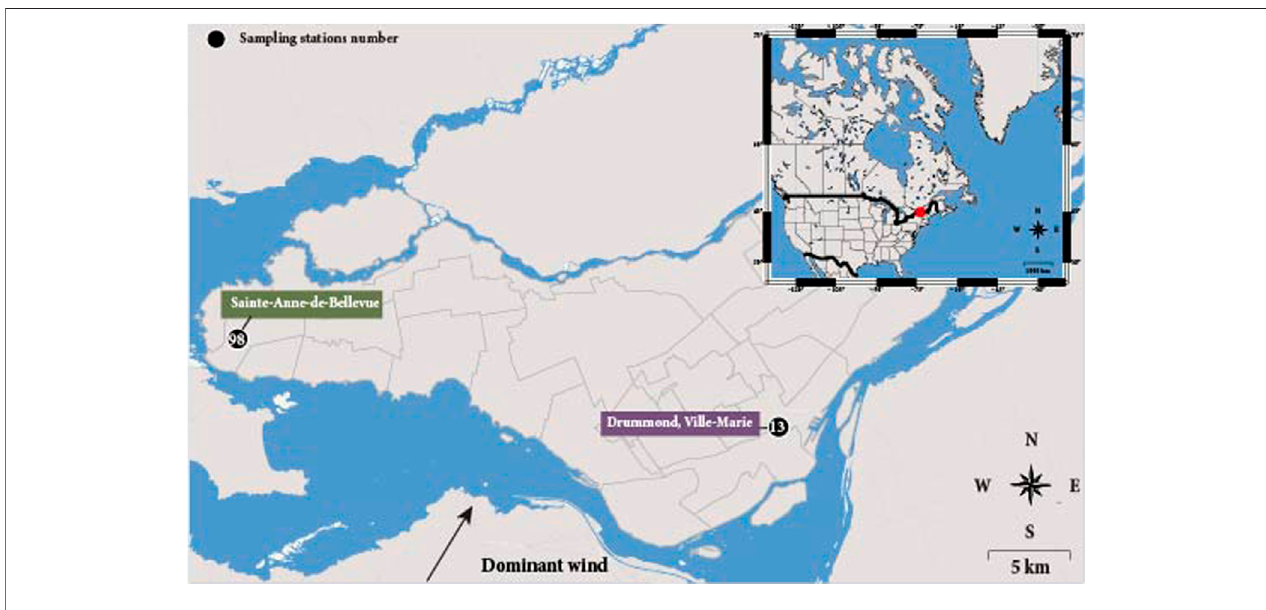
FIGURE 1 | Aerosols sampling locations in